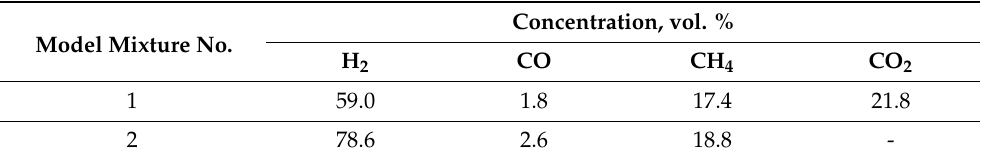
Concentration, vol. %